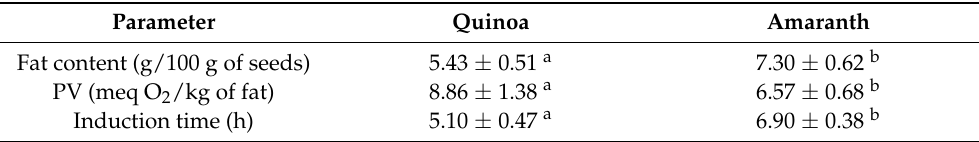
Table 1. Total fat content, peroxide value and Rancimat induction time (h) of fat extracted from quinoa and amaranth